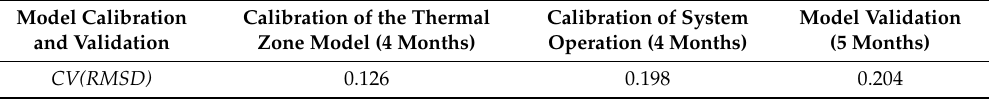
Table 4. CV(RMSD) of heat consumption in model calibration and validation.